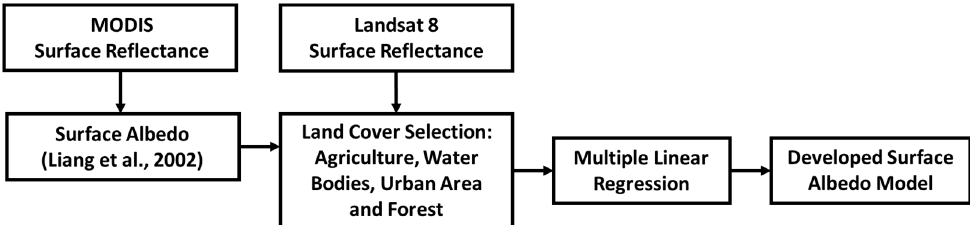
Figure 2. Chart flow of surface albedo model development steps from surface reflectance of the Landsat 8 OLI.